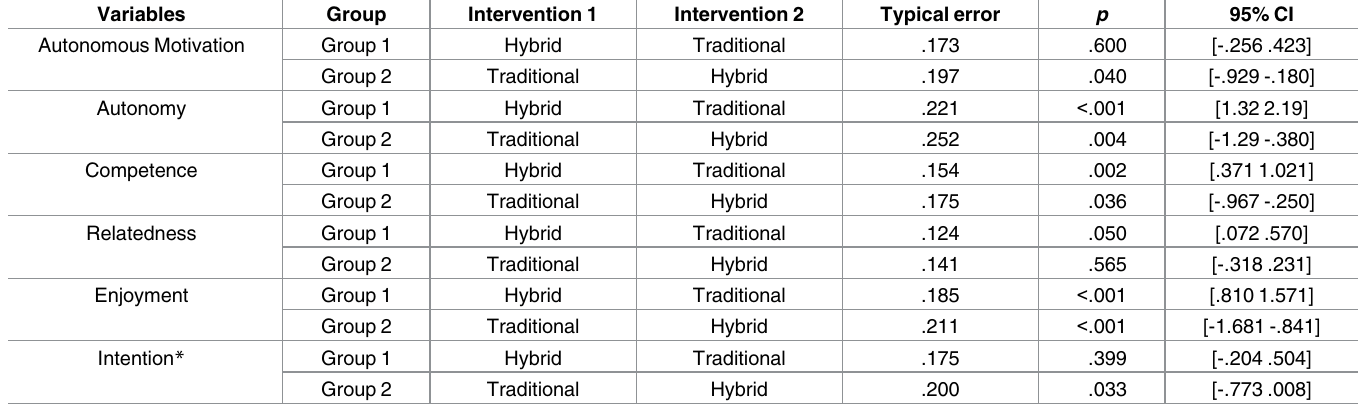
Table 4. Intra-group analysis for both conditions of each dependent